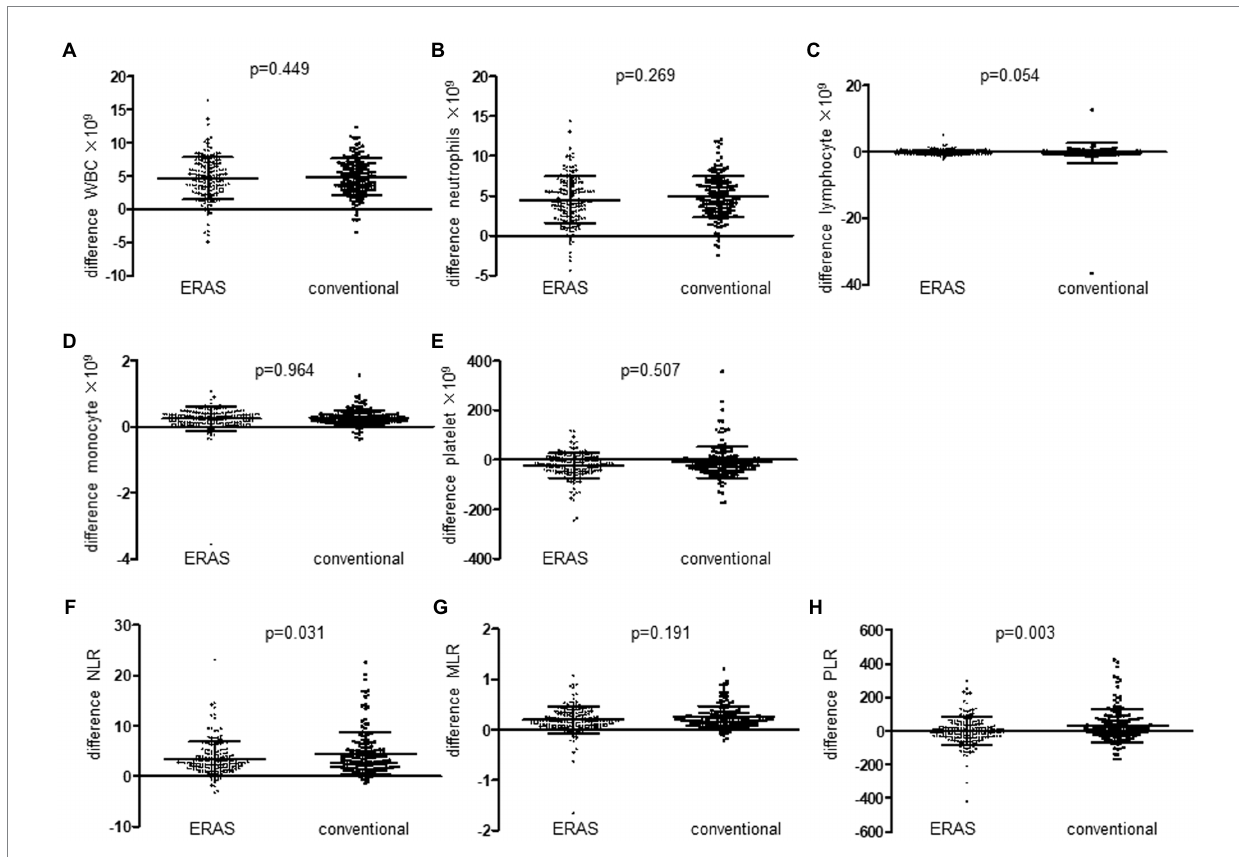
FIGURE 3 Comparison of patients following gynecologic surgery with ERAS programs and patients with conventional programs, in terms of the difference between preoperative and postoperative systemic inflammation response marker, WBC counts (A) , neutrophil counts (B) , lymphocyte counts (C) , monocyte counts (D) , platelet counts (E) , neutrophil-to-lymphocyte ratio (NLR) (F) , monocyte-to-lymphocyte ratio (MLR) (G) , and platelet-to- lymphocyte ratio (PLR) (H)